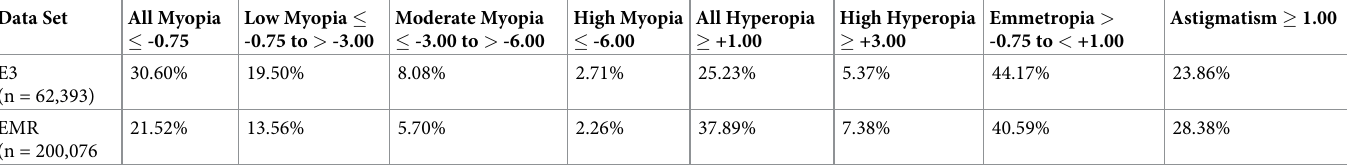
Table 4. Age matched comparison of refractive error rates between the E3 consortium and EMR data (mean age = 60.16 ± 12.23 years). Data Set All Myopia �